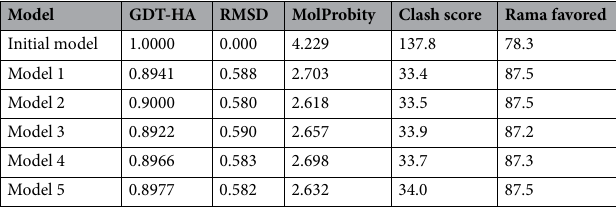
Table 11. Quality scores of the models predicted by